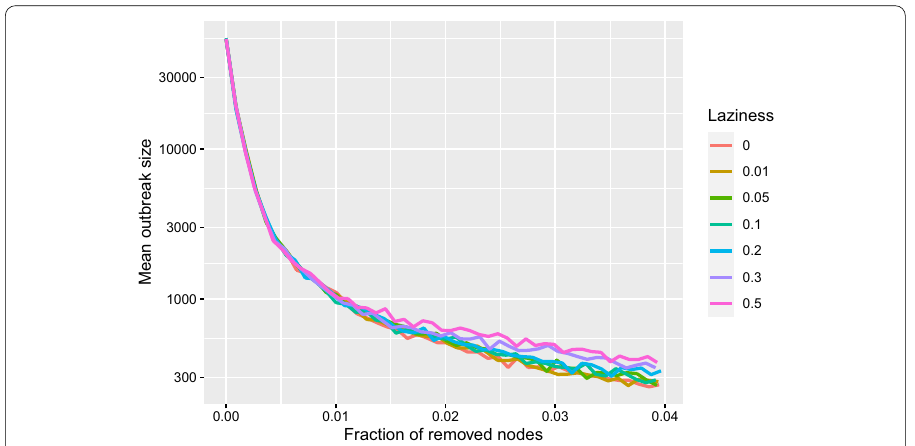
Fig. 6 Mean final outbreak size over 10,000 simulations for an infection on the 2015 complete BDNI network, with nodes removed according to out-TempoRank centrality computed on the 2014 complete BDNI network, with fixed teleportation probability d = 0.15 and varying levels of laziness q (logarithmic scale)